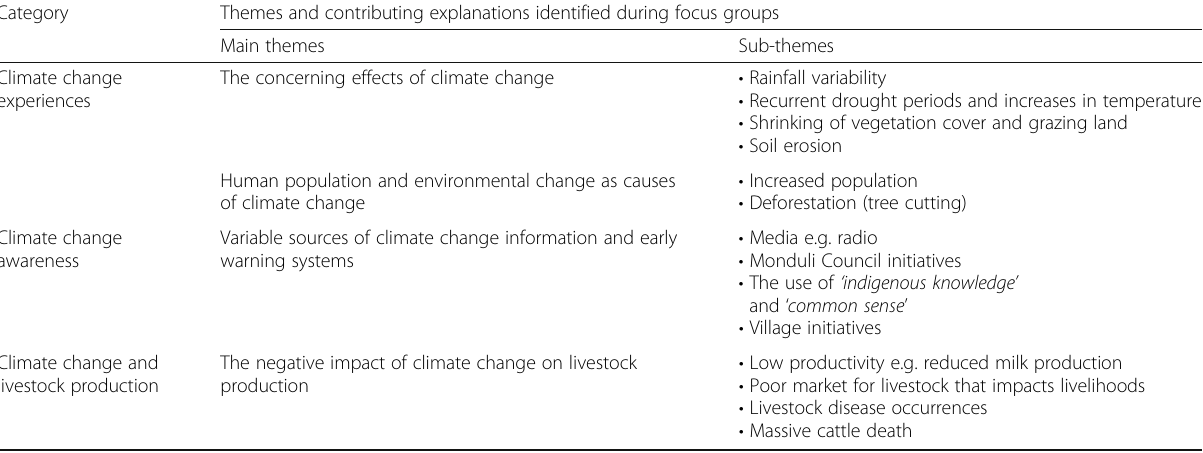
Table 4 Main thematic analysis results summaries. FGD in Monduli District, Northern Tanzania in 2015 Category Themes and contributing explanations identified during focus